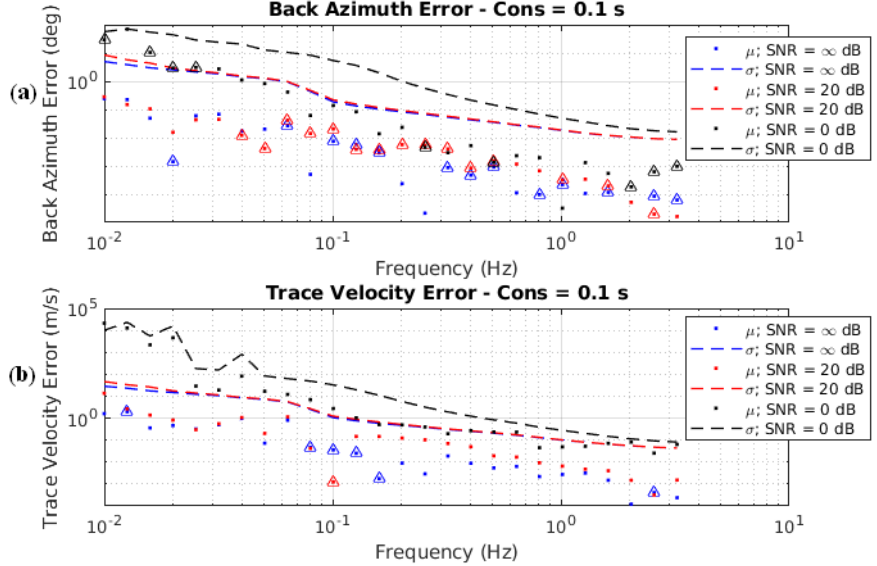
Figure 15. The same as Figure 14, but for the sensor. ( a ) back azimuth and ( b ) trace velocity.